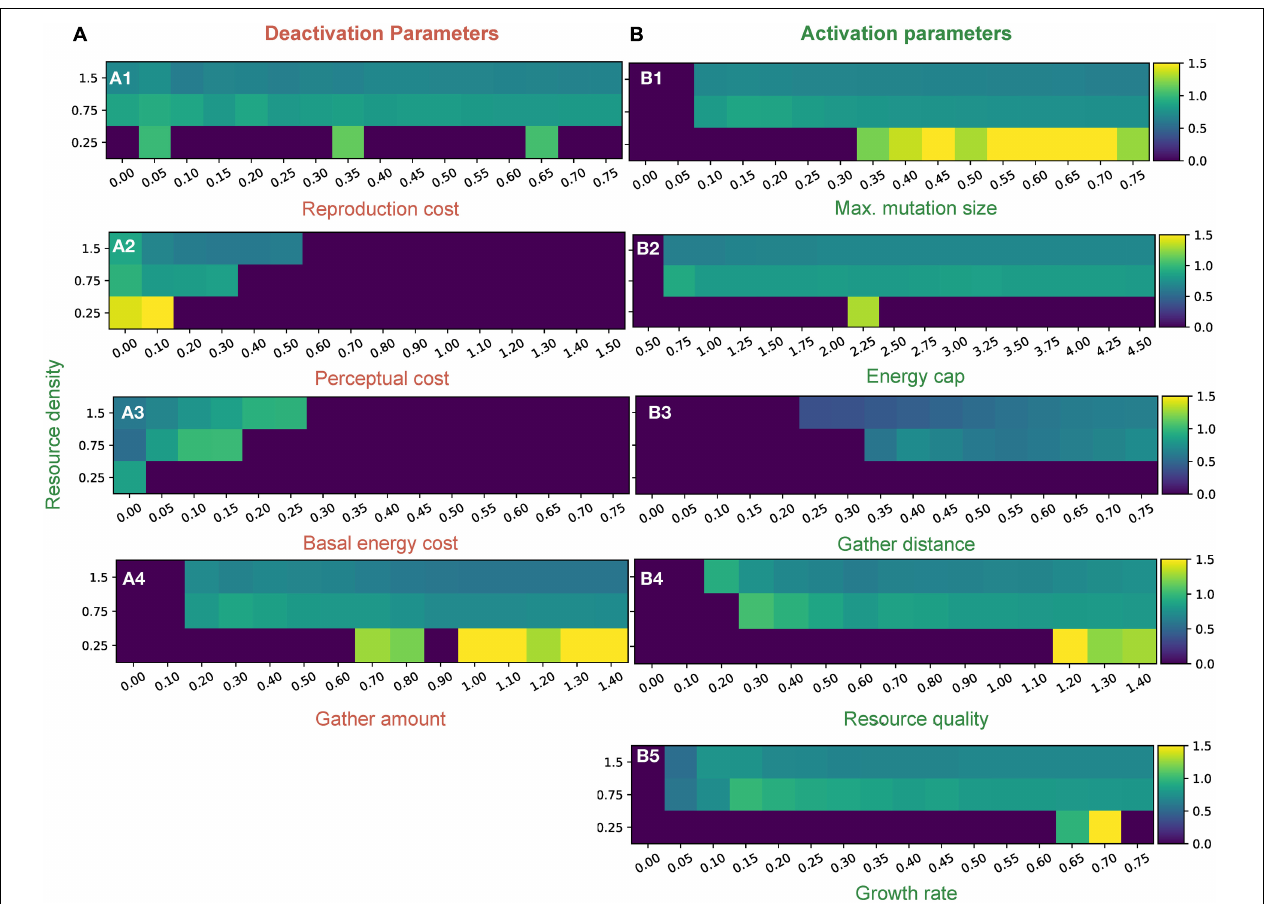
FIGURE 3 | Mean distribution values of perceptual range for different parameters in three different resource density regimes. Column A (A1–4 ) represents deactivation parameters and column B (B1–5) represents activation parameters (The labels in red are deactivation parameters and those in green are activation). Resource densities of 0.25, 0.75, and 1.5 correspond to the “low,” “medium,” and “high” resource conditions, respectively. Detailed distributions of the perceptual ranges and how they are affected by various parameters can be found in Supplementary Figures 5, 6